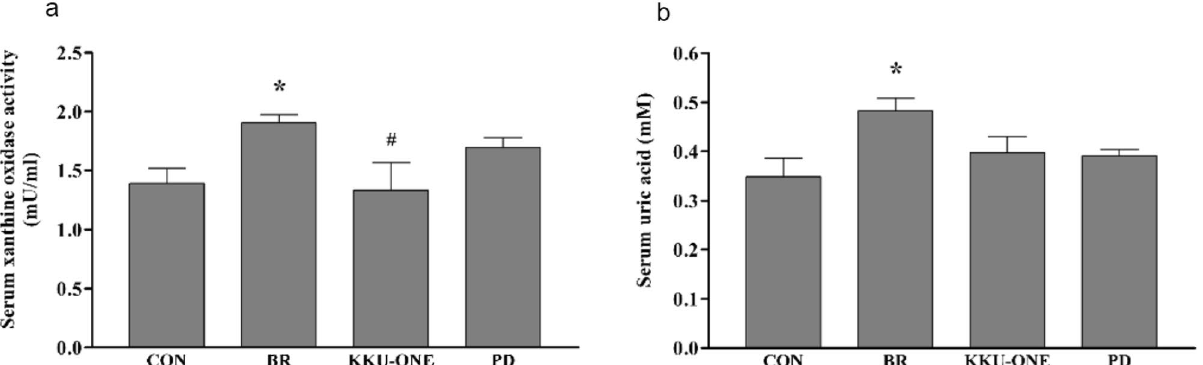
Figure 2. Effect of high protein chicken breast meat diet on ( a ) serum xanthine oxidase activity and ( b ) uric acid levels in rats. Data are expressed as means ± SEM. (n = 5–7 animals/group); * p < 0.05 vs. CON, # p < 0.05 vs. BR; CON: control group, BR: commercial broiler group, KKU-ONE: commercial broiler × Thai native crossbred group, PD: Thai native chicken (Pradu Hang Dam) group.